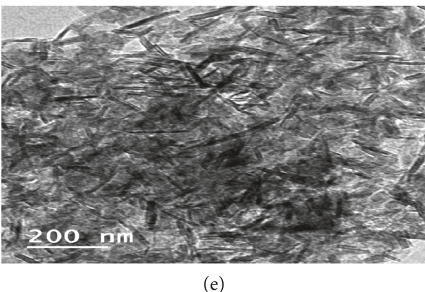
Figure 4: (a) TEM photo of prepared sample A. (b) TEM photo of prepared sample B. (c) TEM photo of prepared sample C. (d) TEM photo of prepared sample (D). (e) TEM photo of prepared sample E.